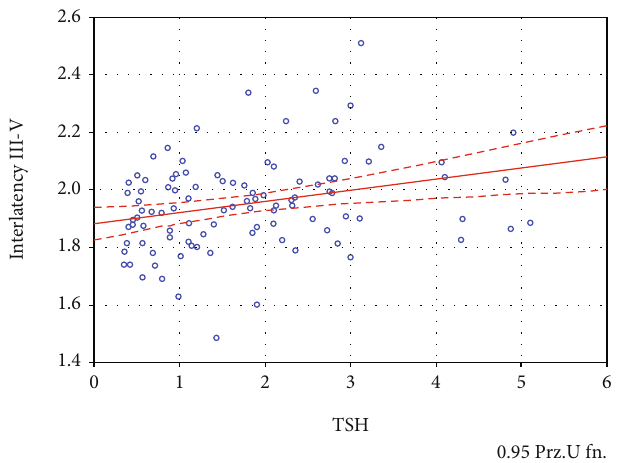
Figure 3: Correlation of III-V wave BAEP with TSH